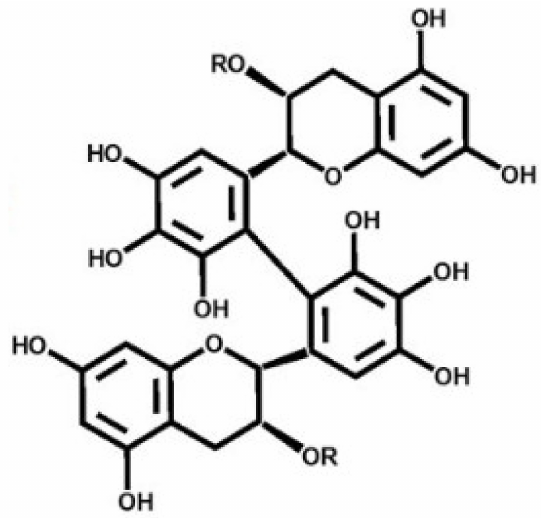
Figure 1. Structure of theasinensin A (TSA). TSA was synthesized by the enzymatic reaction of epigallocatechin gallate